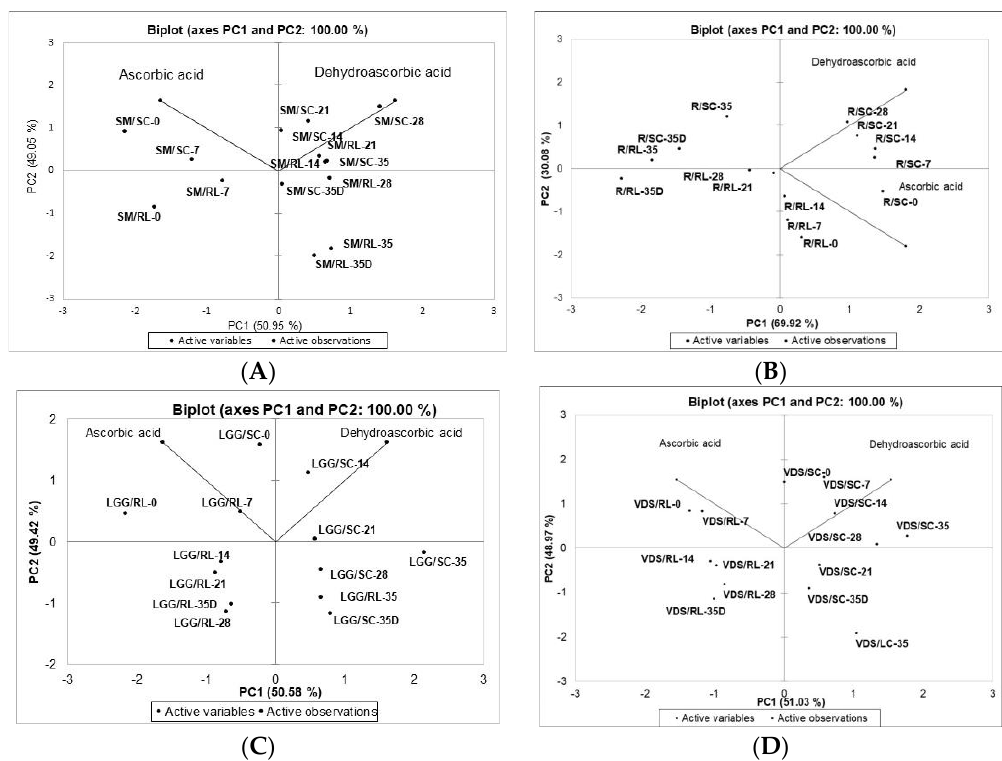
Figure 4. Principal component analysis (PCA) of AA and DHAA in juices from different scion/rootstock combinations subjected to 0, 7, 14, 21, 28, and 35 days of storage in transparent bottle and dark bottle (35D). ( A ) SM — Sanguínea de Mombuca; ( B ) R — Rubi; ( C ) LGG — Lue Gin Gong; ( D ) VDS — Valencia Delta Seedless; RL —‘Rangpur’ lime; CS—‘Swingle’ citrumelo.